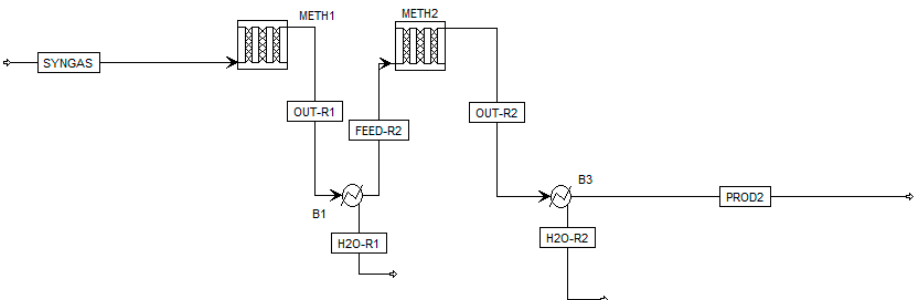
Figure 4. Aspen simulation model showing a two-stage methanation process with intermediate product gas cooling.